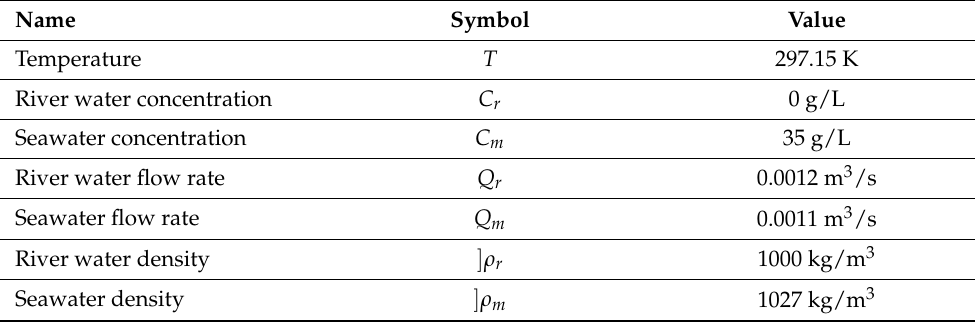
Table A5. Sea and river water properties at the inlet of any of the stack membrane modules.